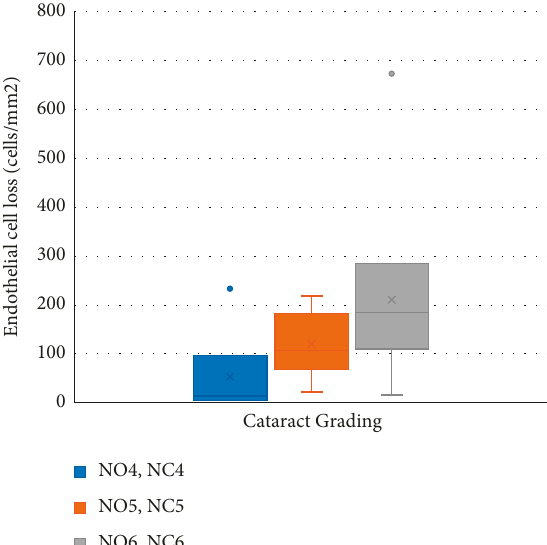
Figure 2: The box and whisker plot showing correlation between different cataract grades and the mean endothelial cell loss (NO: nuclear opalescence; NC: nuclear